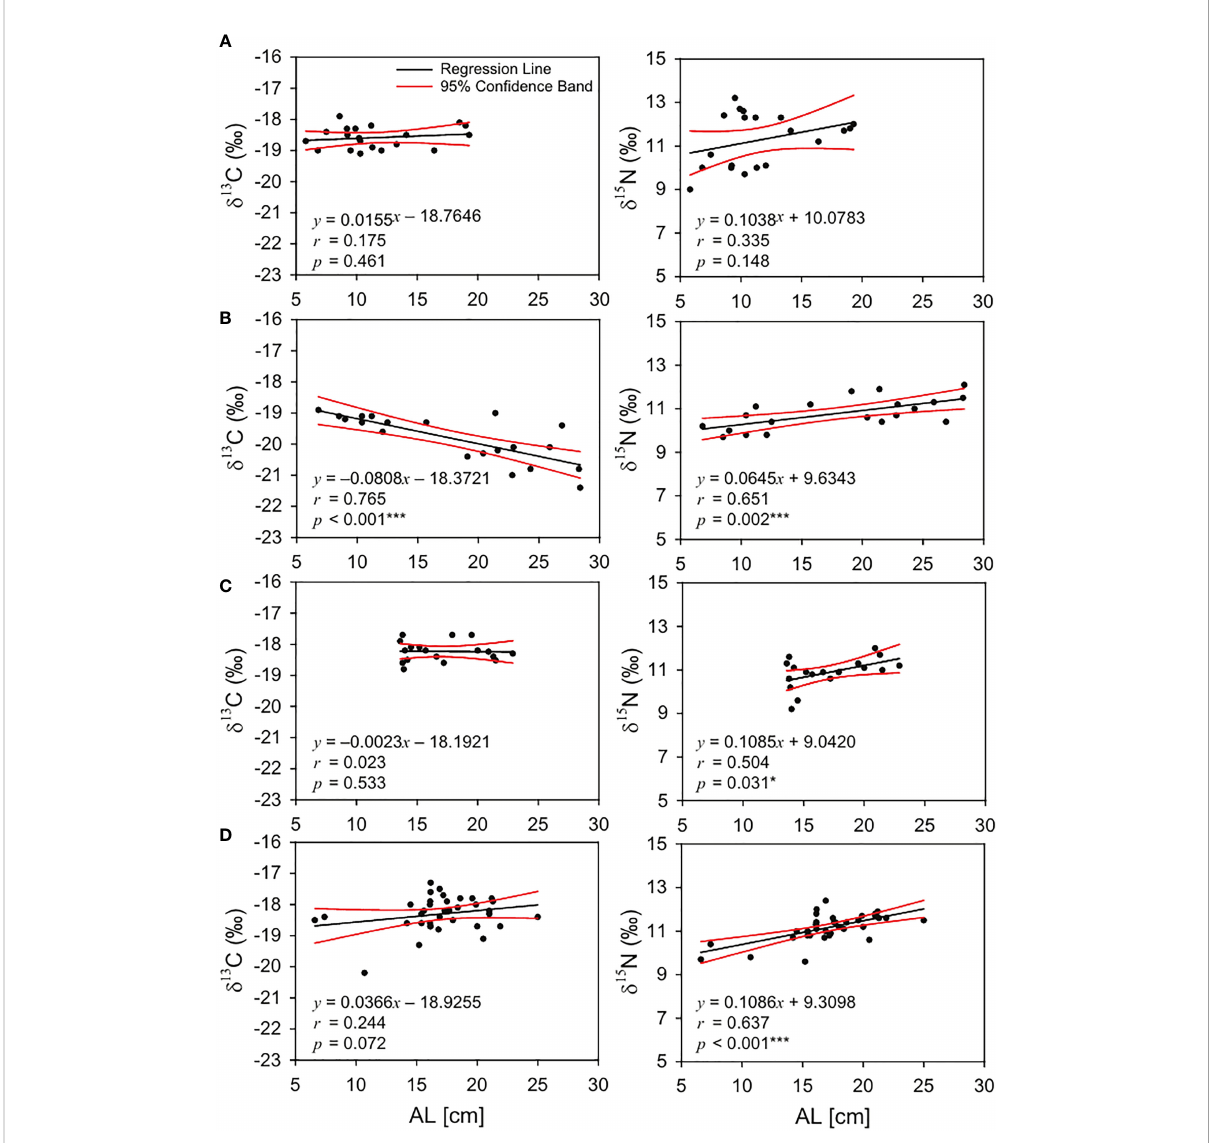
FIGURE 4 Regression relationships between d 13 C – anal length (cm, left) and d 15 N – anal length (cm, right) of large-head hairtail ( Trichiurus japonicus ) collected in the South Sea of Korea during February (A) , May (B) , August (C) , and November (D) 2021, *, p < 0.05 and ***, p <